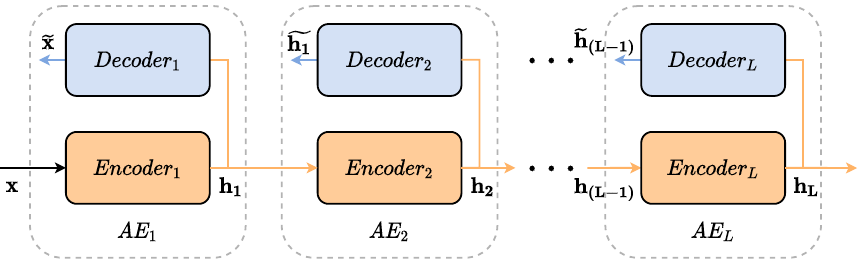
Figure 2. Stacked Autoencoders schematic